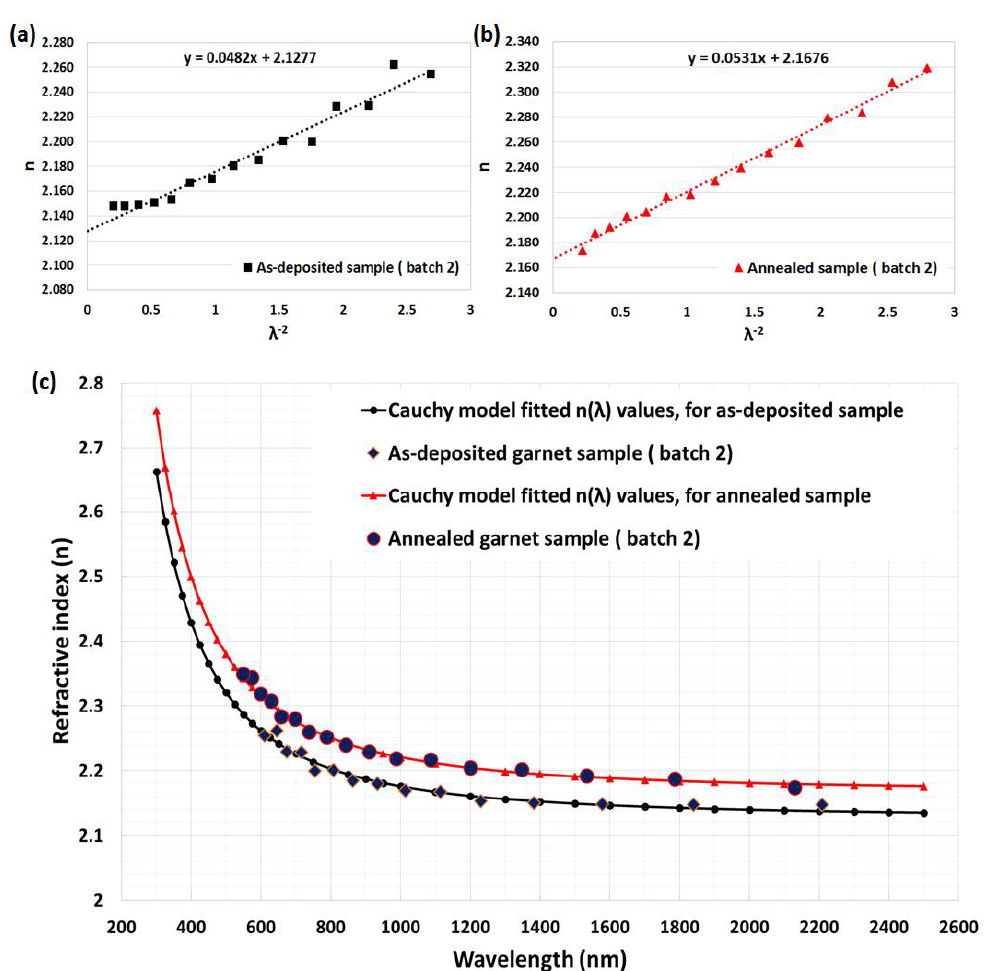
Figure 8. Least square fit of calculated refractive index (n 2 ) values for garnet samples (batch-2); ( a ) as-deposited and ( b ) annealed. ( c ) Calculated refractive index spectra using Cauchy’s model and measured transmission spectra, for as-deposited and annealed samples.